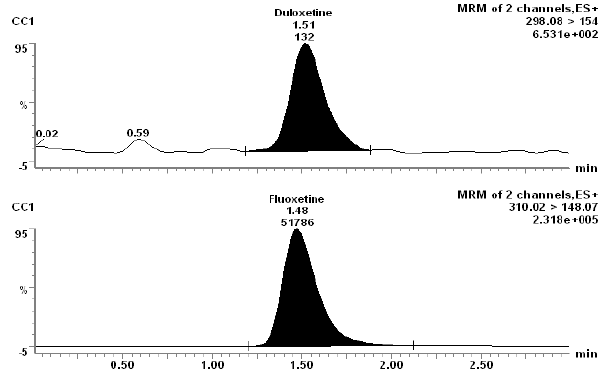
Figure 3. (d) Duloxetine and Fluoxetine at LLOQ (m/z) 298.08  154.0.